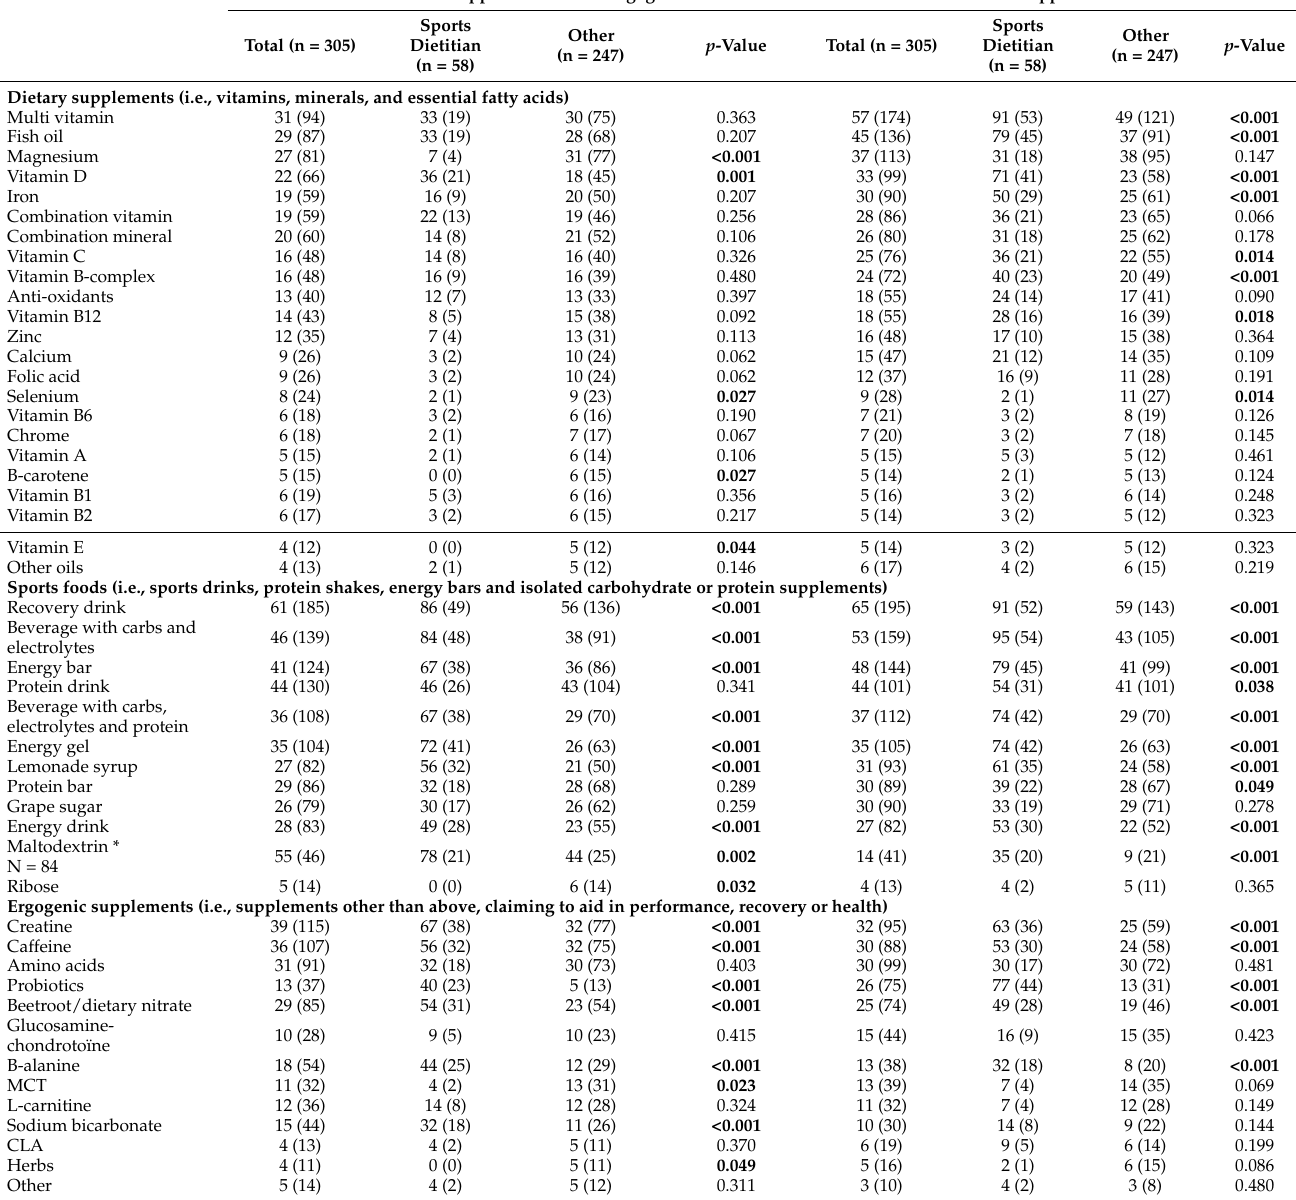
Table A1. Perception of ergogenic effect of nutritional supplements and if professionals advise these nutritional supplements for the total groups of sports health professionals and stratified for sports RDs and other